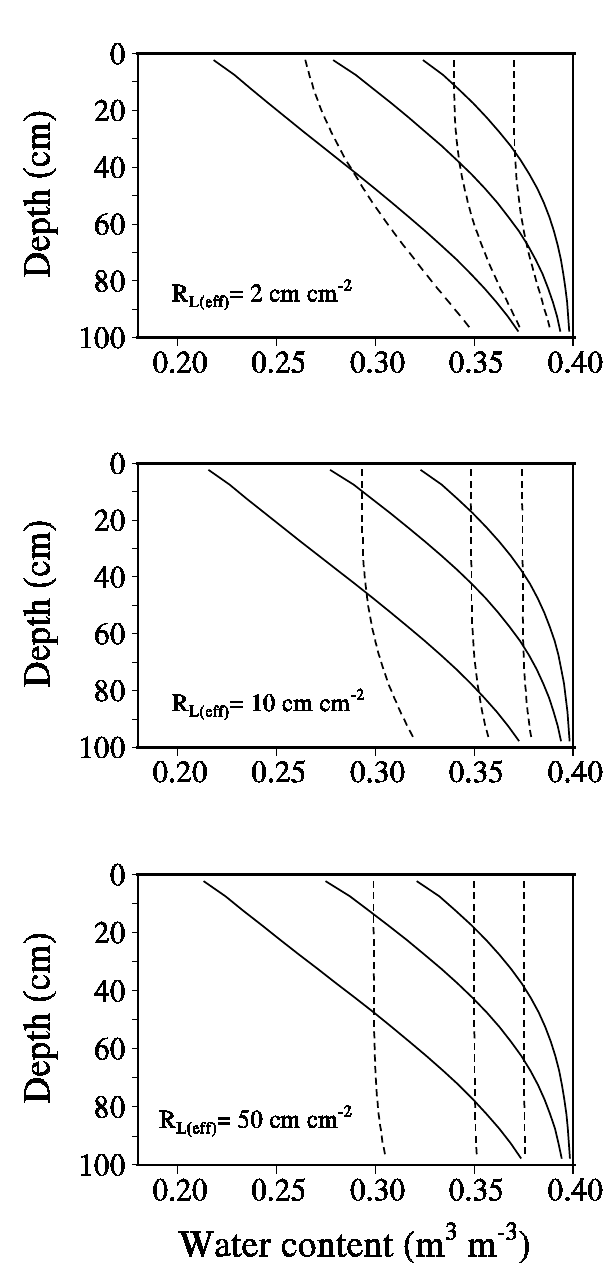
Fig. 2. Water content distributions during dry-down from satura- tion, simulated with Eqs. (1) to (4) after 5, 10 and 20 days, assuming M 0 to be given by Eq. (8) (dashed lines) or Eq. (17) (solid lines). Parameter values are given in Table 1, initial/boundary conditions in the text.